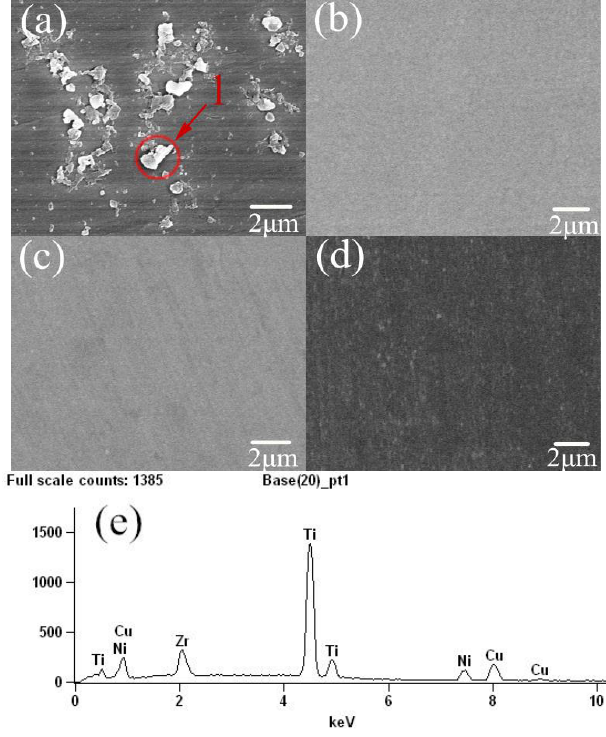
Figure 2. Microstructures at low magnification of the TA–Six filler metals ( a ) x = 0%; ( b ) x = 0.5%; ( c ) x = 1.0%; ( d ) x = 2.0%; ( e ) energy dispersive spectrometry (EDS) of the highlighted region (point 1) in Figure 2a.